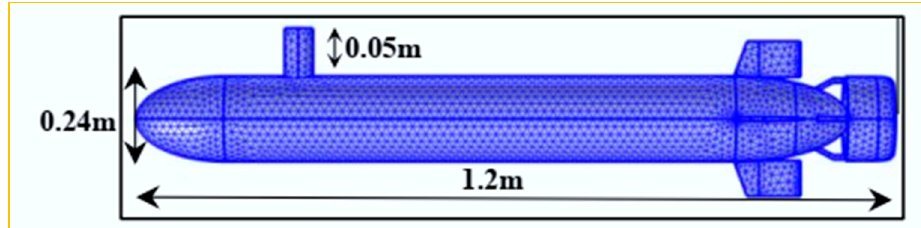
Figure 1. COMSOL Simulation model of proposed acoustic target strength.